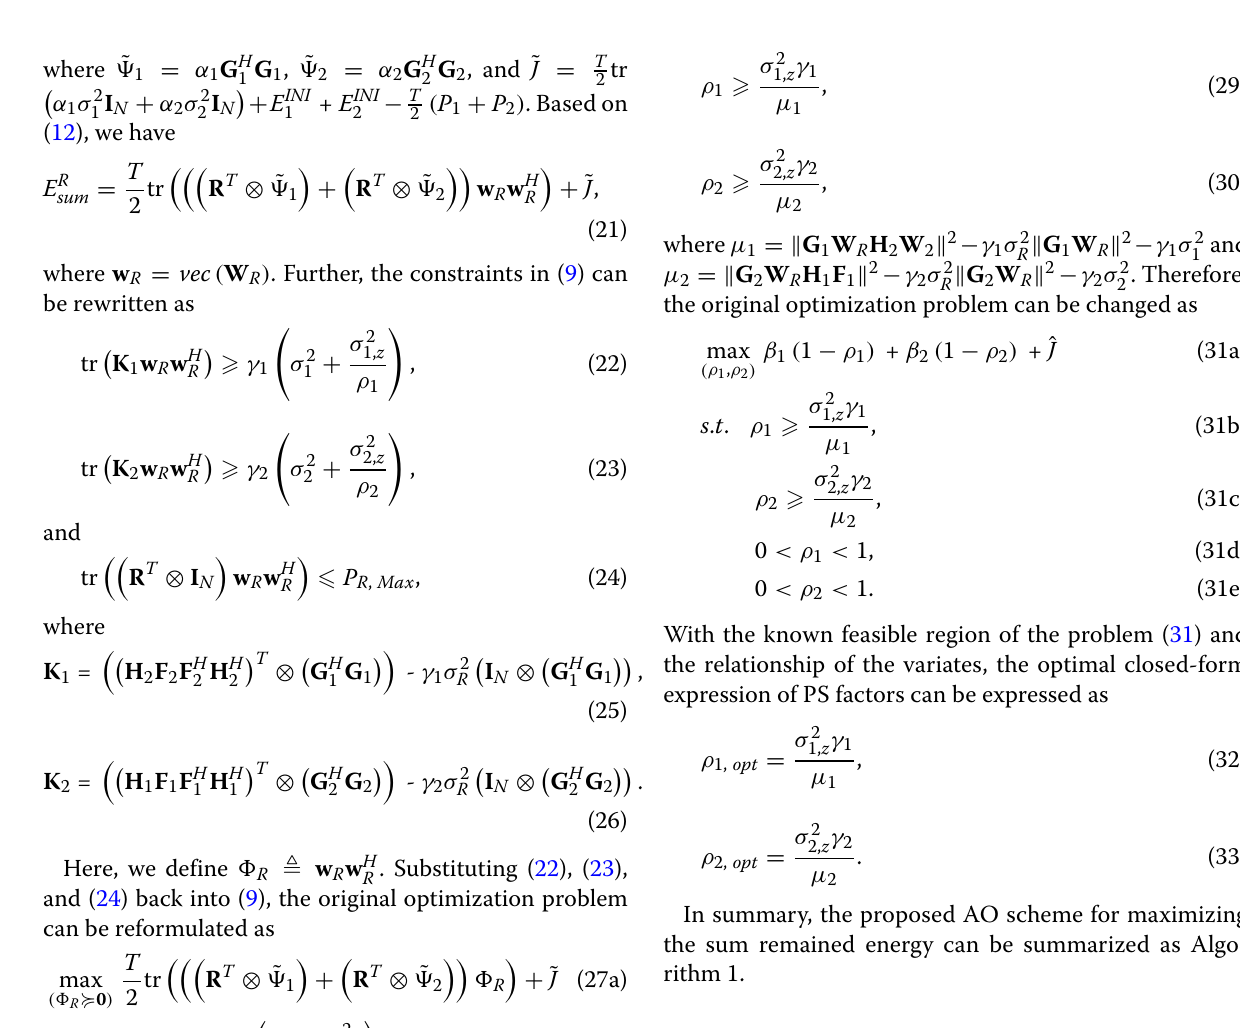
Algorithm 1 The proposed AO scheme for